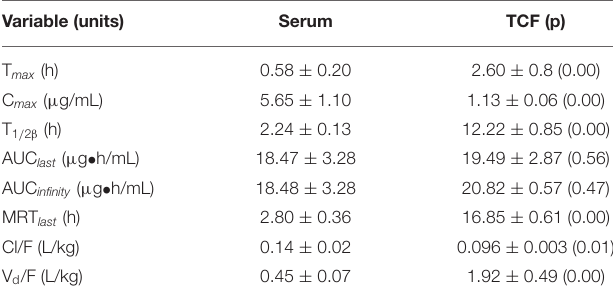
TABLE 3 | Pharmacokinetics of cefquinome in serum and TCF after intramuscular administration at 2 mg/kg body weight. Variable (units)